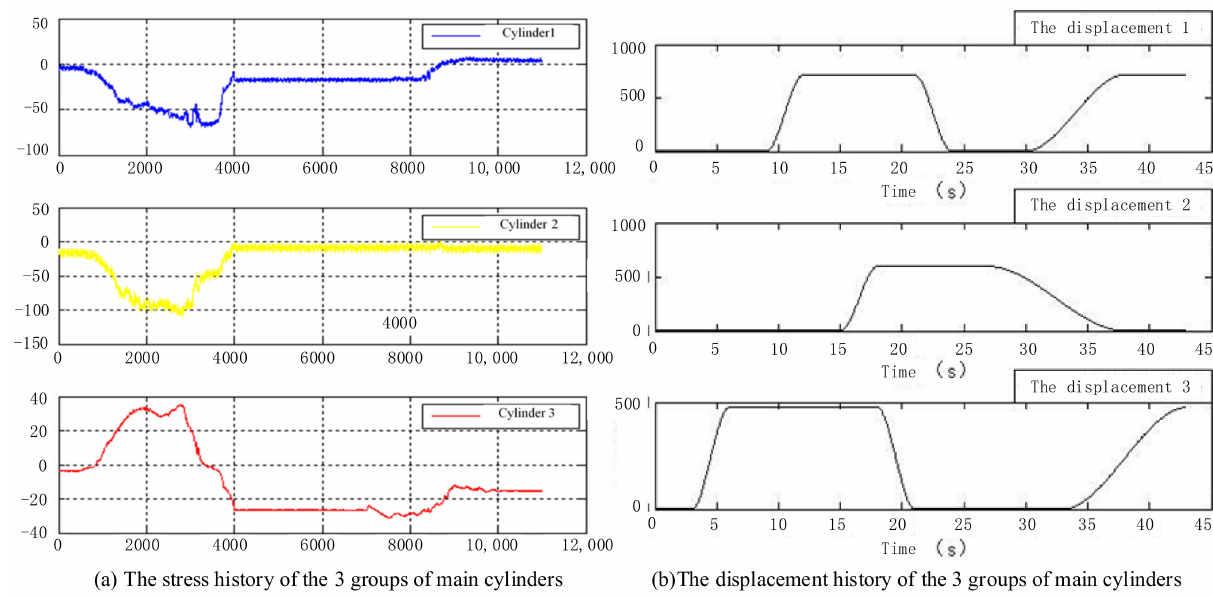
Figure 10. The stress and displacement history of main cylinders.